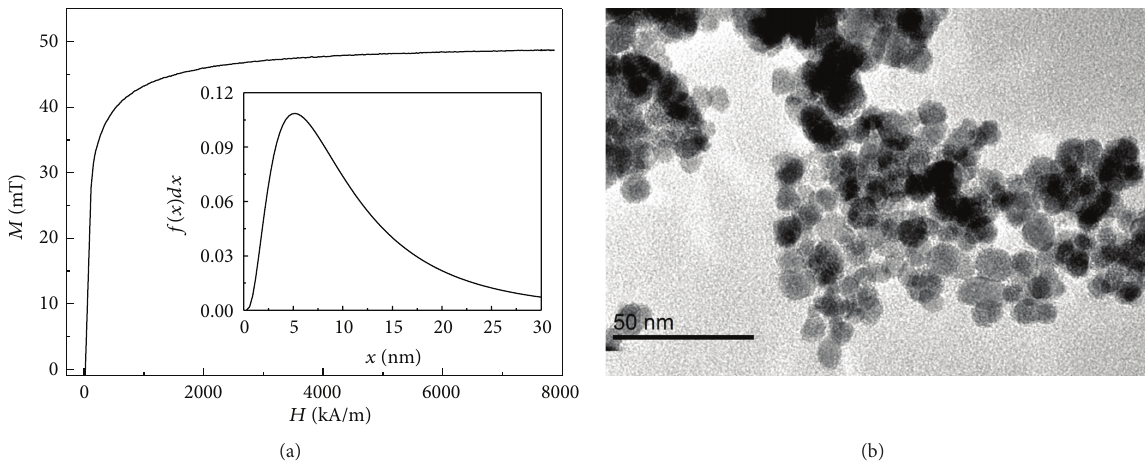
Figure 1: (a) Magnetization curves M ( H ) for oil suspension of magnetic nanoparticles, obtained from SQUID and magnetite particle size distributions ( inset ). (b) Transmission electron microscope images of superparamagnetic nanoparticles prepared by coprecipitation